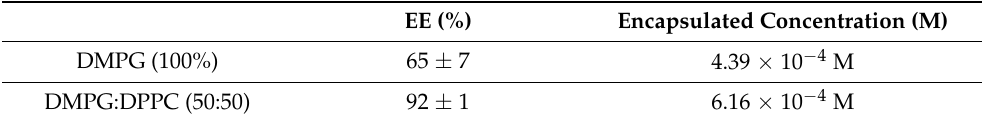
Table 4. Encapsulation efficiency (EE%) of compound 3f in DMPG (100%) and DMPG/DPPC (50:50) liposomes and concentration of encapsulated compound.